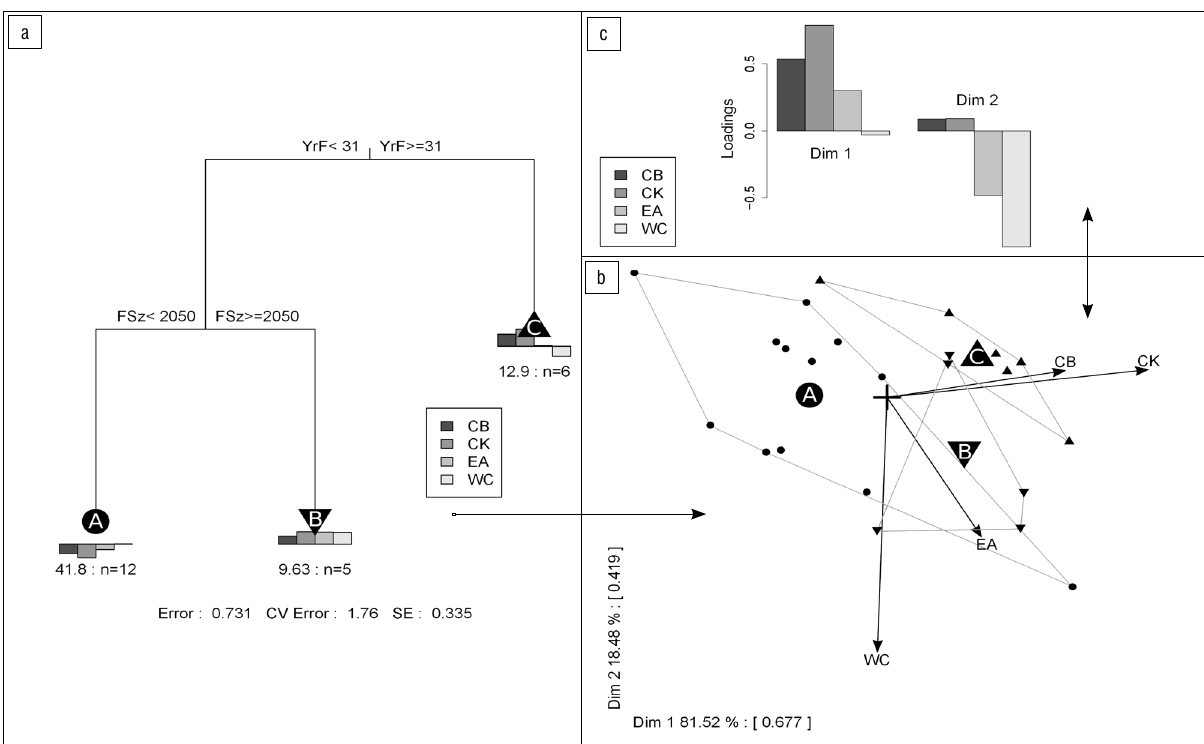
Figure 2: (a) Multivariate regression tree (MRT) of the predictors of the latent variables (LVs). The model has an approximate R 2 of 0.2698, meaning it explains approximately 26.98% of the variance of the LVs. Bars show deviations from the grand mean of each scale. (b) Distance (i.e. row- preserving) biplot of the constrained principal component analysis on instrumental variables (PCAIV). The origin of the biplot represents the average position. Convex hulls delimit each group and the big points within each hull show the centroid (or MRT-predicted mean) of each group. An estimate of respondents’ individual-level scores on the LVs may be derived by orthogonally projecting the small points onto the vectors of the LVs. The values in square brackets after the variance explained by each dimension are interset correlations, the correlation between respondents’ scores on each dimension and the LVs. (c) Variable loadings on dimensions 1 and 2 of the PCAIV shown in